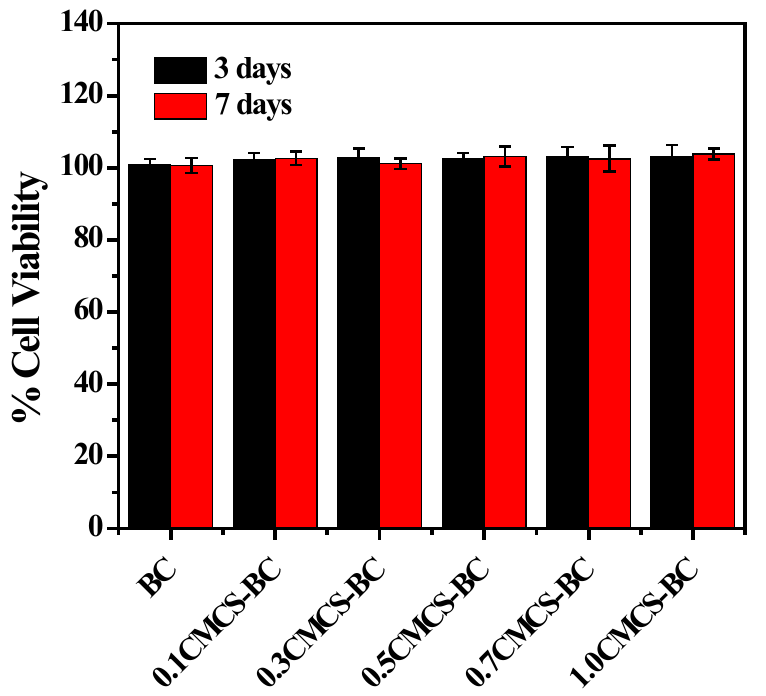
Figure 6. MTT assay cell proliferation of hydrogels for skin fibroblast cells.